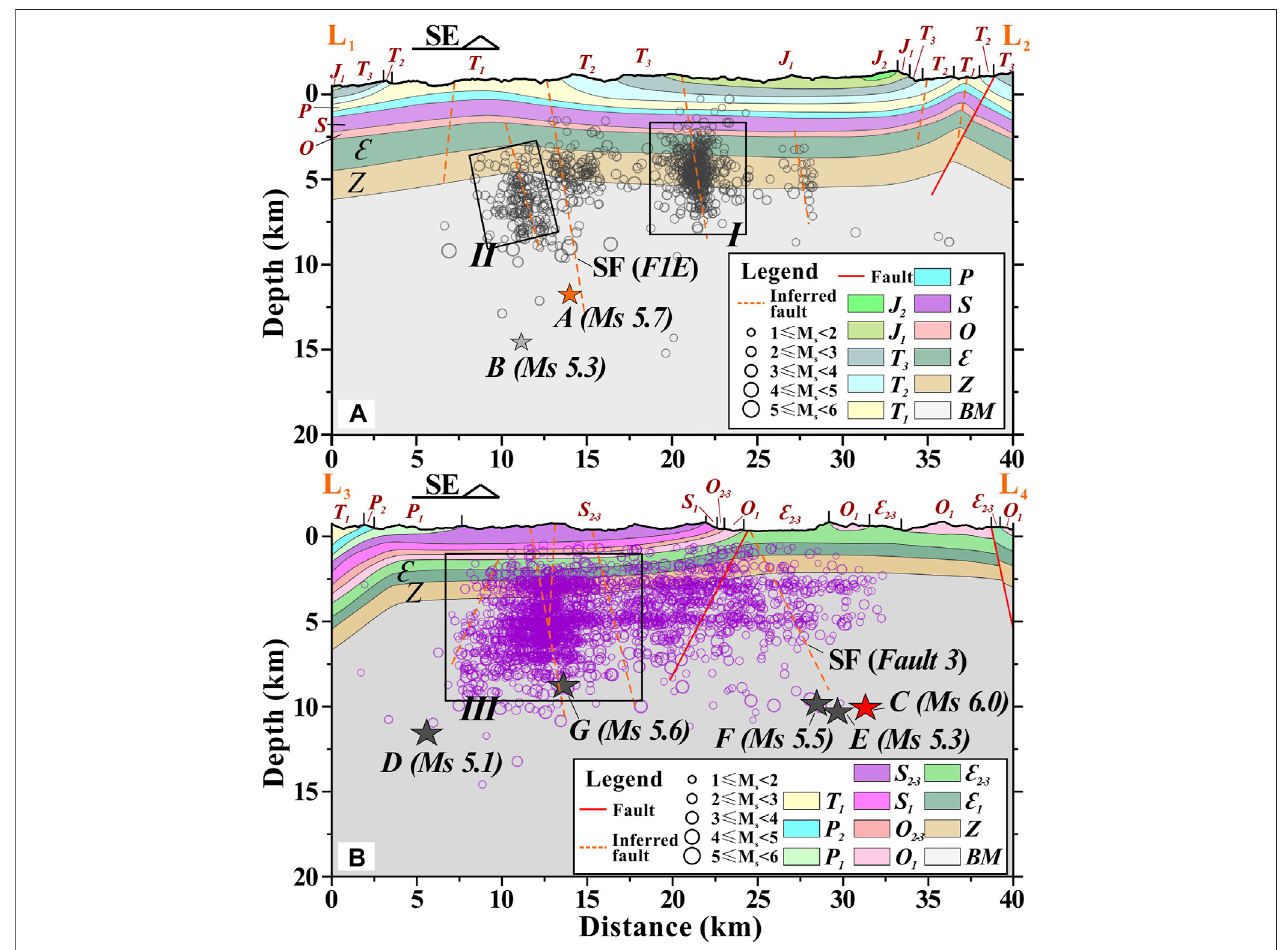
FIGURE6 | Geological sections withfaults laidatop theprojected earthquakes within 5 kmof Pro fi les L 1 – L 2 and L 3 – L 4 in Figure 1D . The geological sections were drawn based on a 1:200,000 geological map. SF: Seismogenic fault; BM: Proterozoic and Archaeozoic basement.